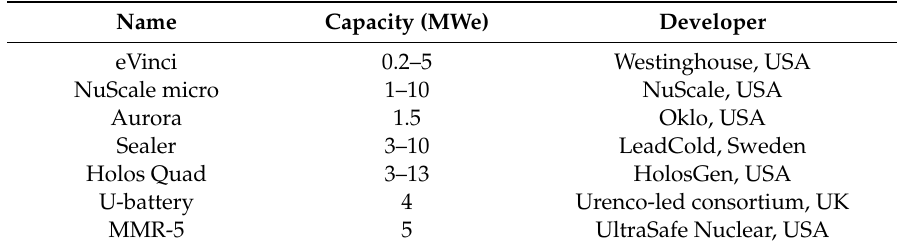
Table 1. A list of microreactors